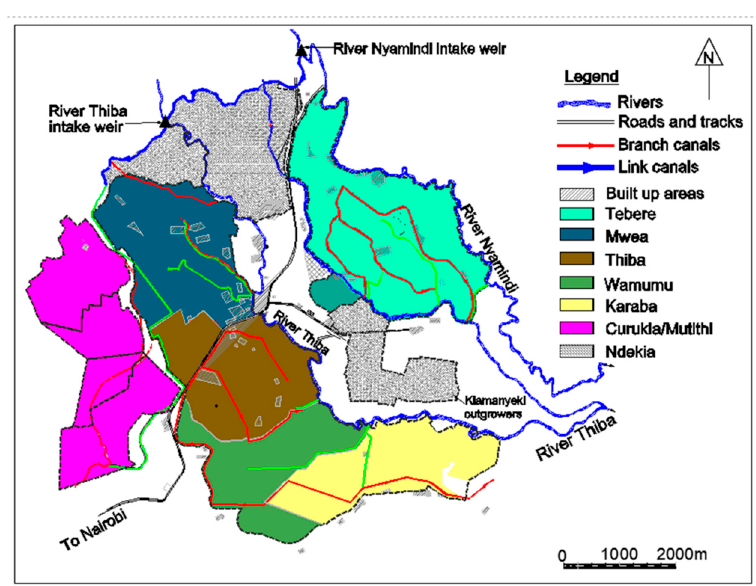
Figure 2. Mwea Irrigation Scheme (MIS) irrigation blocks layout.